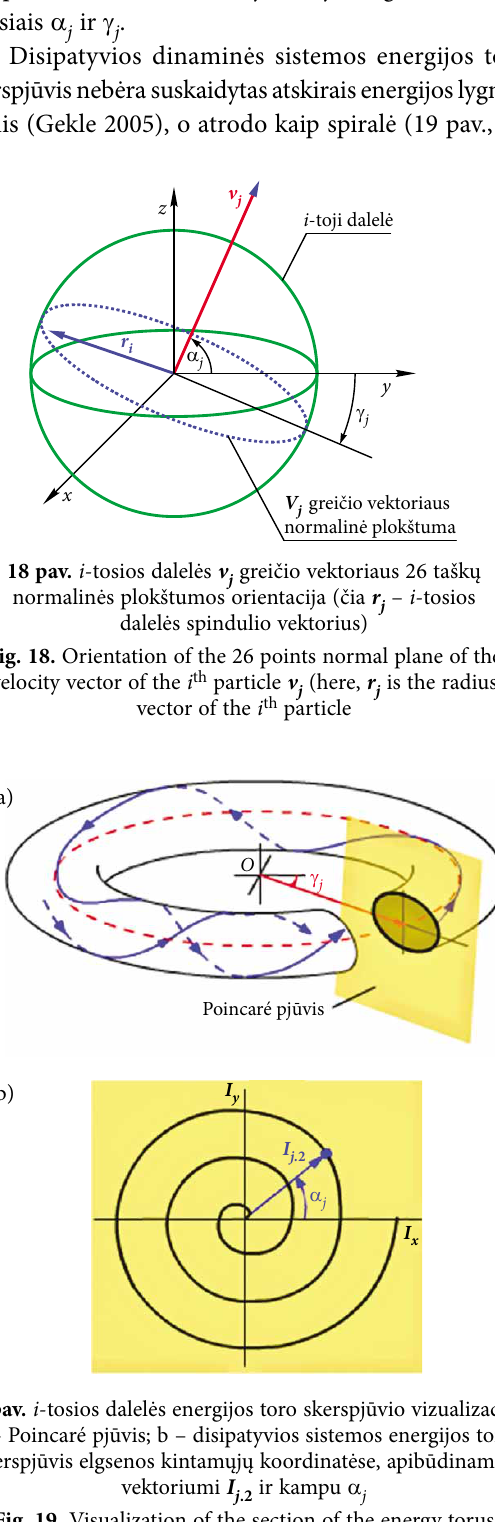
Fig. 19. Visualization of the section of the energy torus of the i th particle: a – Poincaré section; b – the section of the energy torus of the dissipative system is defined using and angle (cid:68) vector I j .2